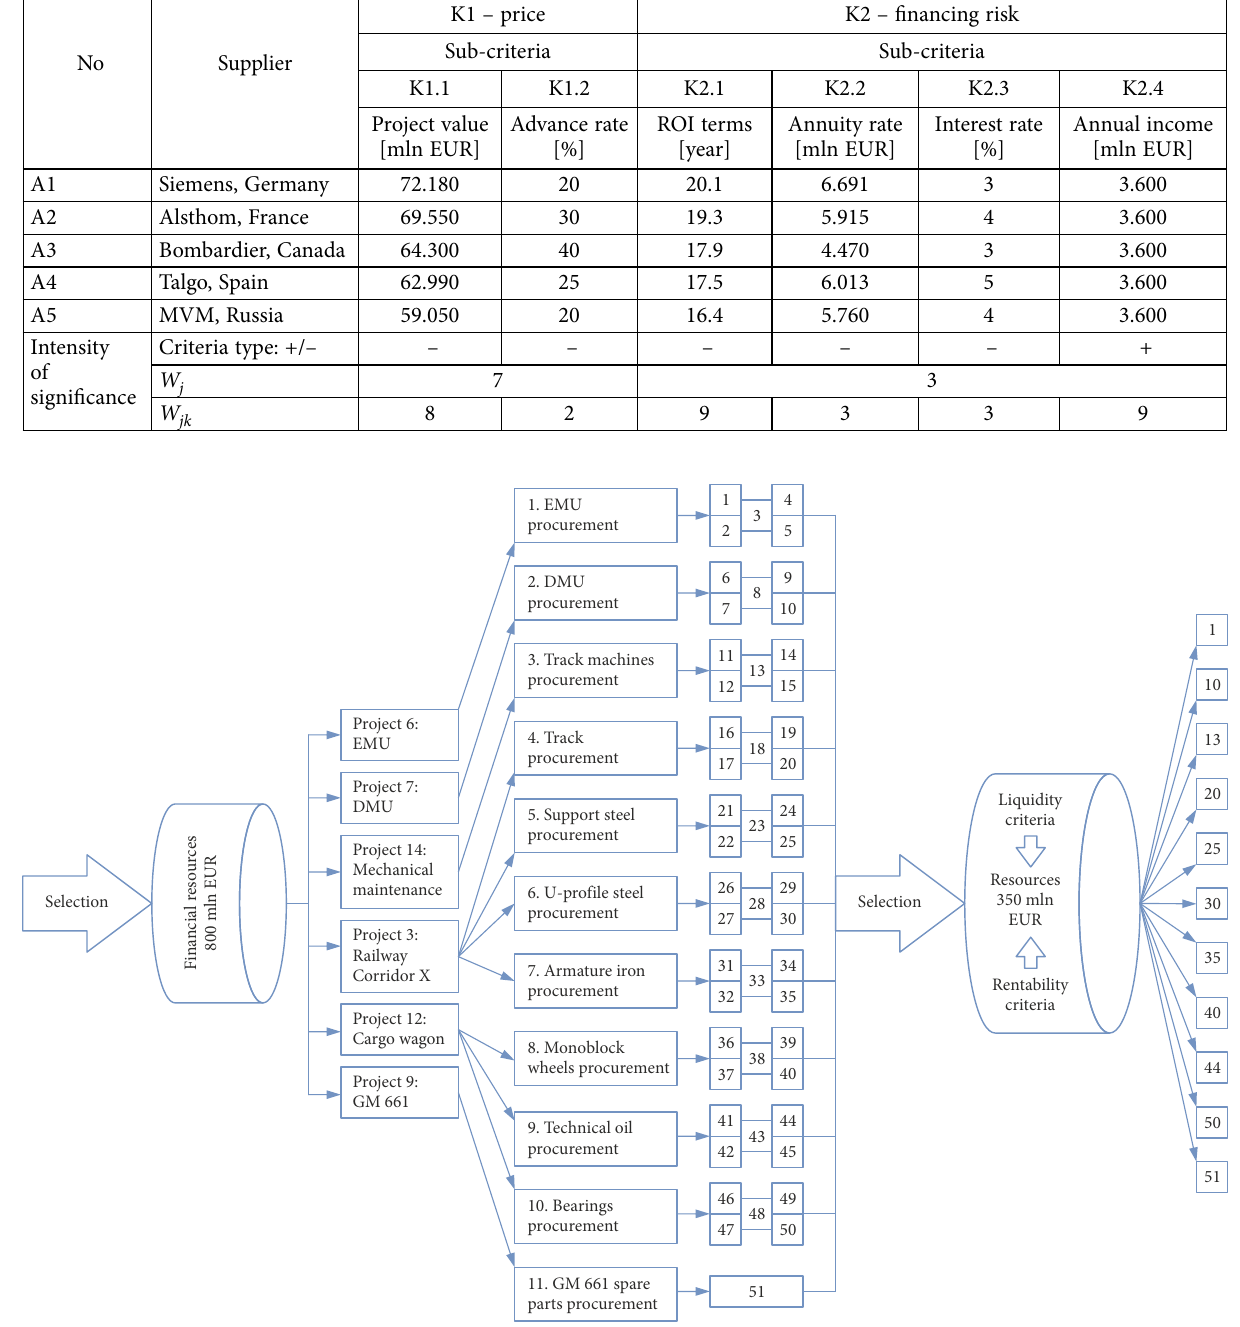
Figure 3. Railway modernization project (phase II) – procurement projects supplier choice model (created by